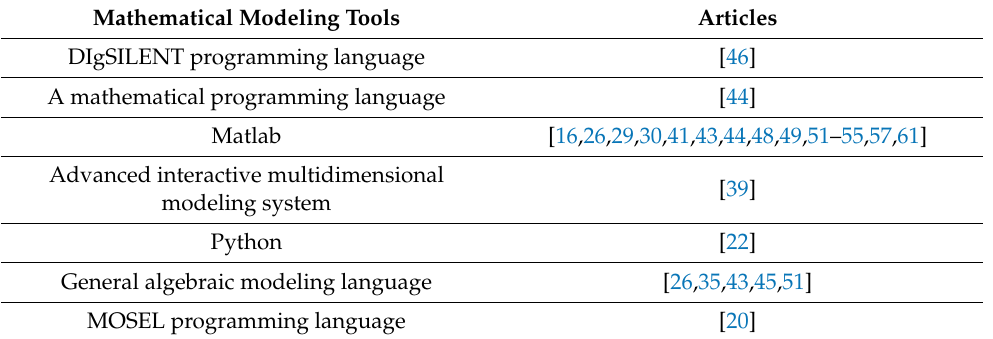
Table 5. Mathematical modeling